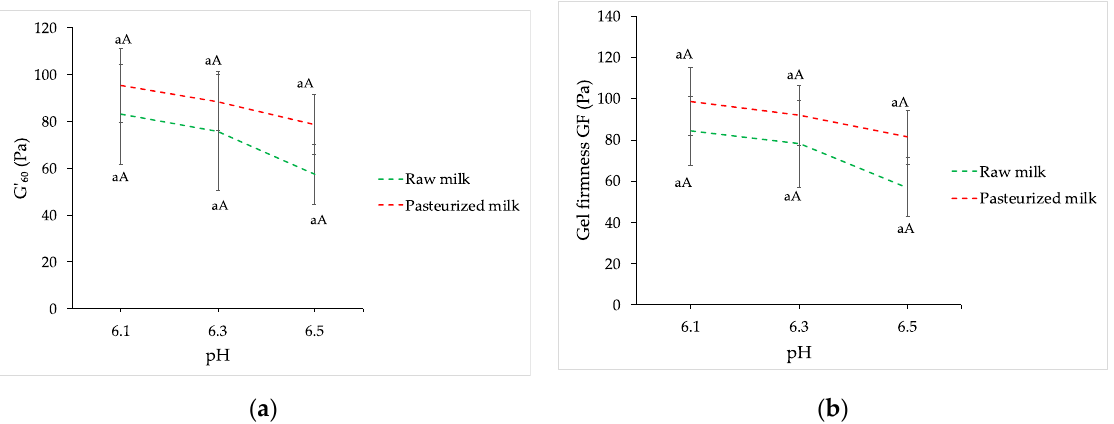
Figure 5. Influence of milk pH and heat treatment of milk on: ( a ) gel firmness G’ 60 (Pa) and ( b ) GF (Pa). Values with lowercase letters indicate no differences between levels of milk pH, and uppercase letters indicate no differences between milk heat treatments (raw/pasteurized). Comparison of means was performed by LSD test ( p < 0.05).